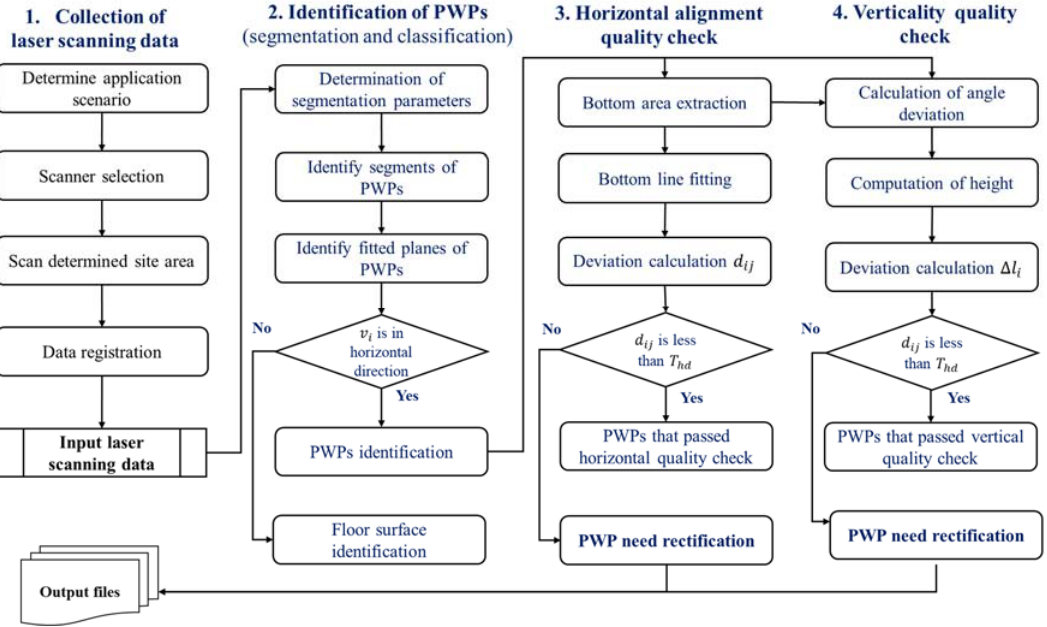
Figure 3. IQC process.